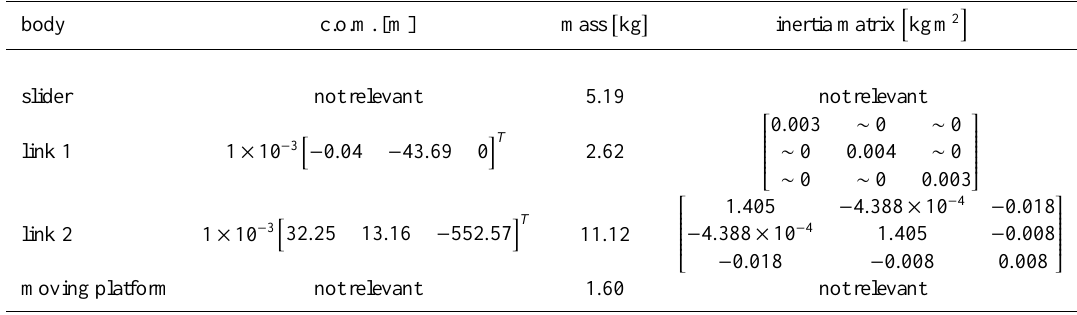
Figure 6. Multibody model of I.Ca.Ro. parallel manipulator. Table 1. Phisical characteristics of the I.Ca.Ro. robot